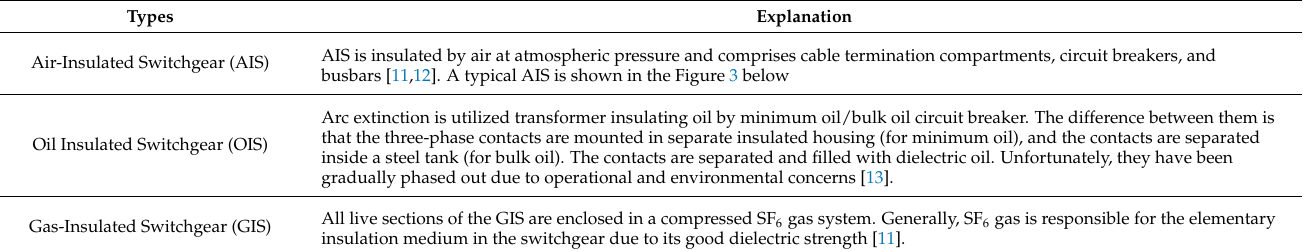
Table 1. The three types of switchgear.